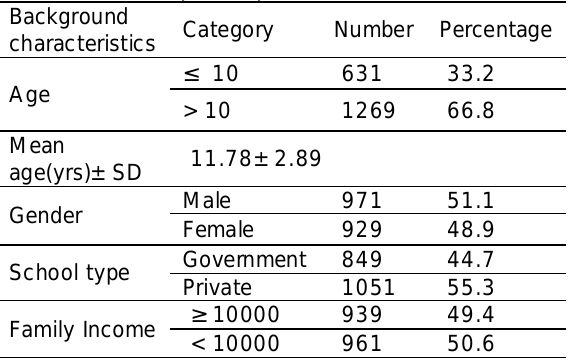
Figure 1: BMI of the Respondents (n=1900)